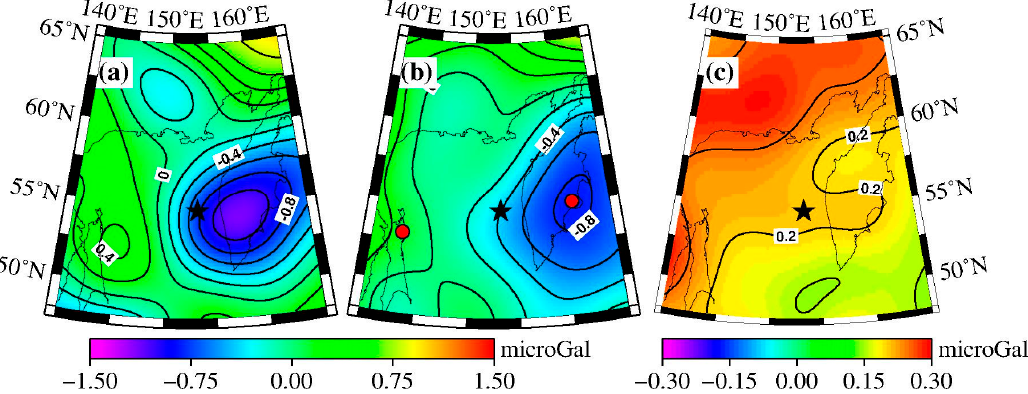
Figure 1. Distribution of coseismic gravity changes measured by GRACE. The P4M6 and 350 km Gaussian filter were applied. ( a ) Coseismic gravity changes retrieved by the difference method. ( b ) Coseismic gravity changes retrieved by the least square fitting (LSF). The black star represents the epicenter. The red points show the locations of the time series of the GRACE-obtained gravity changes. ( c ) Post-fitted errors of coseismic step (denoted by H in formula (2). The gravity change contour interval is 0.2 microgal in a/b, and 0.01 in (c).